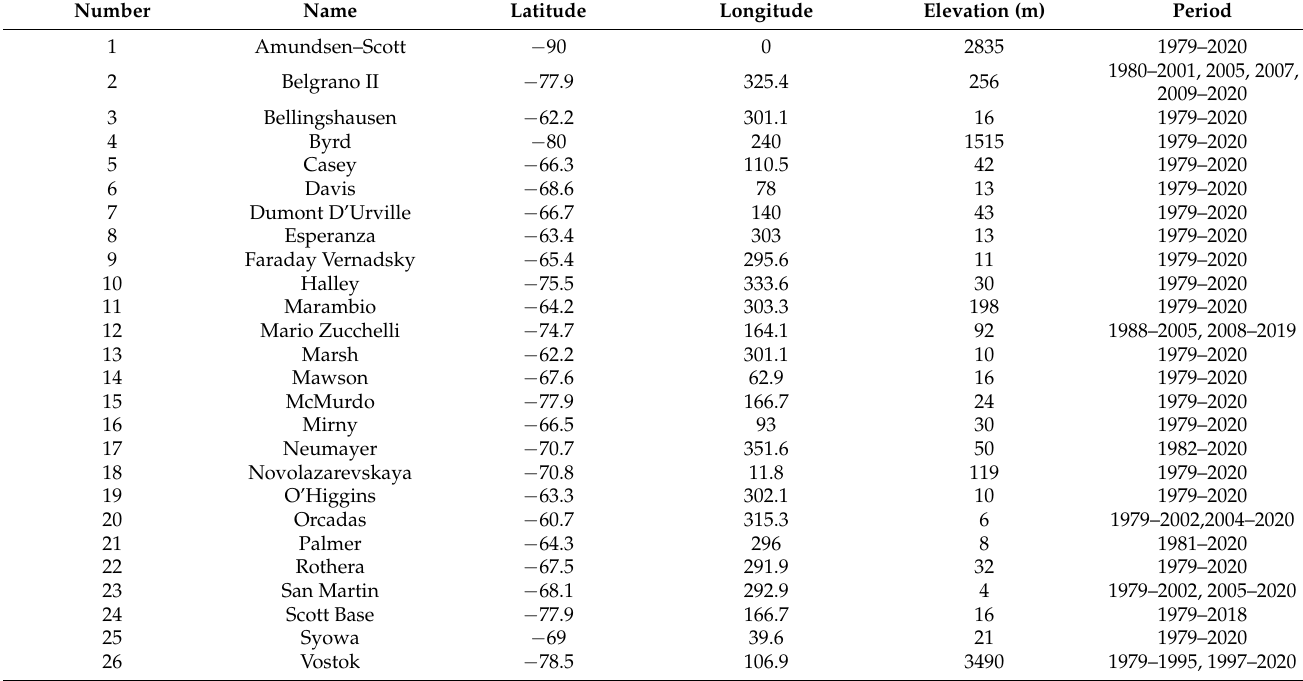
Table 1. Stations used in this